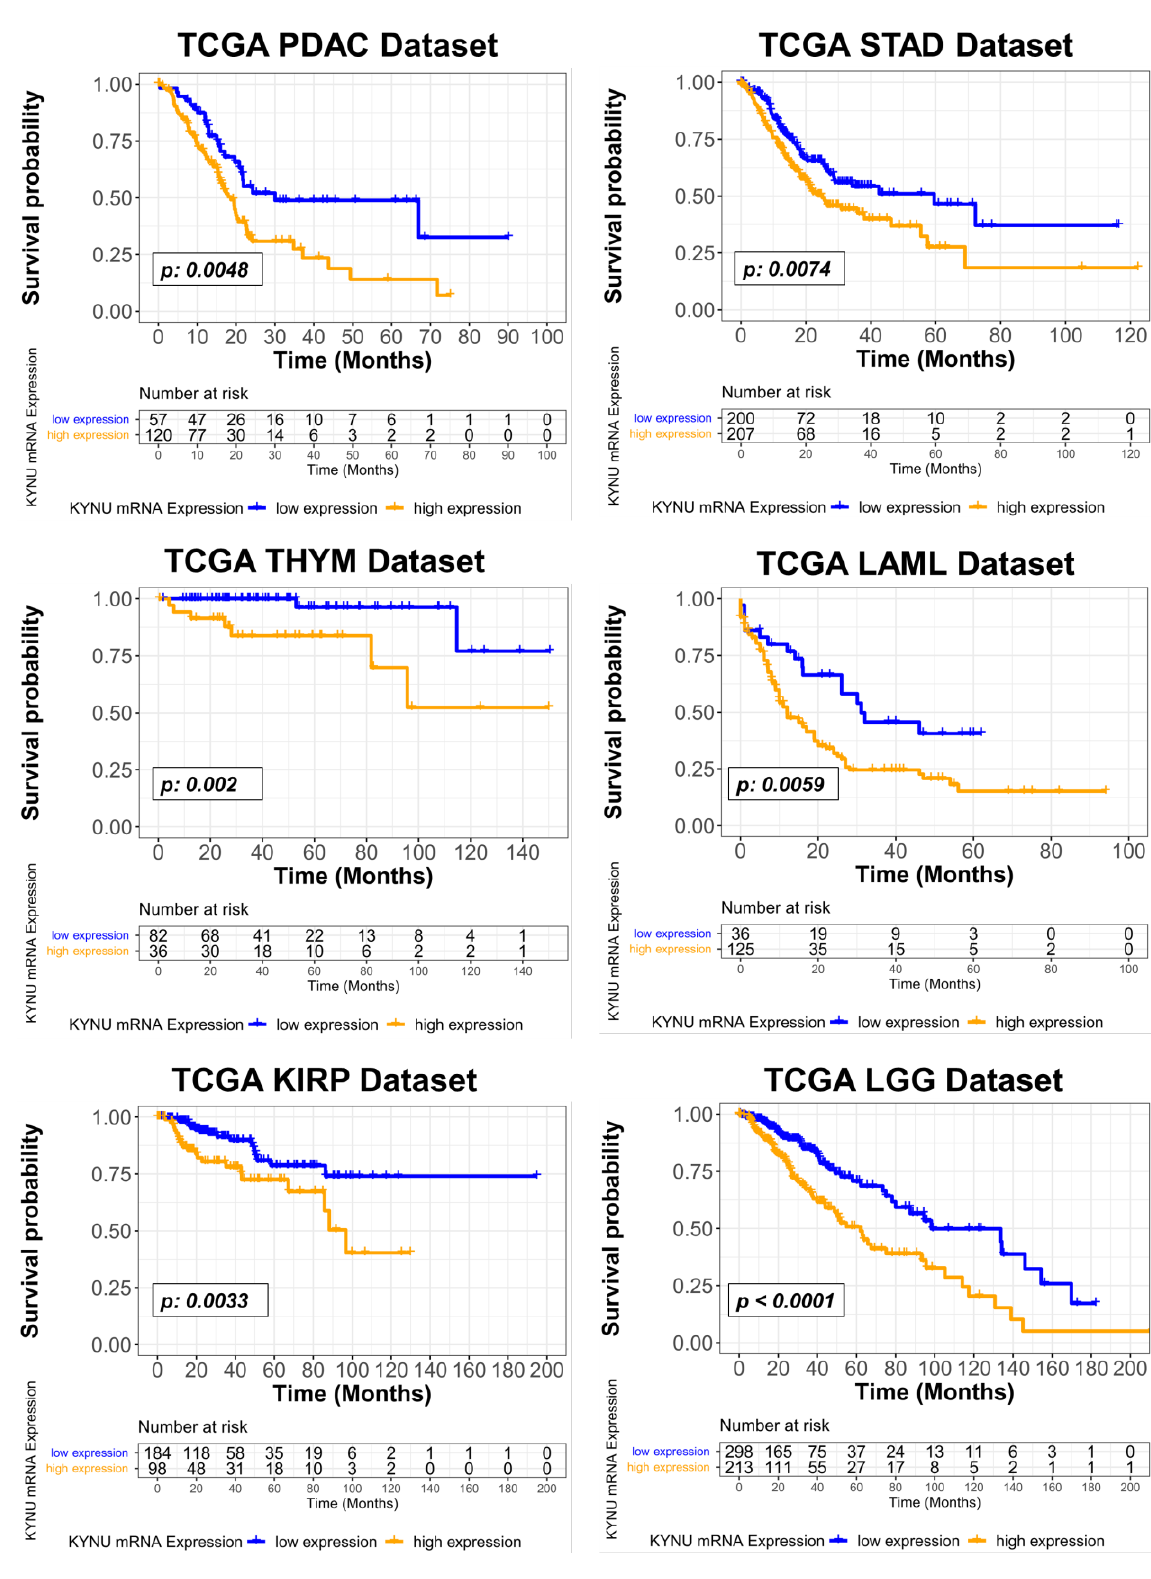
Figure 5. Kaplan–Meier curves for overall survival in PDAC, stomach adenocarcinoma (STAD), kidney renal papillary cell carcinoma (KIRP), thymoma (THYM), acute myeloid leukemia (LAML), and low-grade glioma (LGG) TCGA datasets based on KYNU mRNA levels at an optimal cutoff value. The optimal KYNU cutoff was derived using the method described by Contal and O’Quigley [16]. Statistical significance was determined by two-sided log-rank Mantel – Cox test.